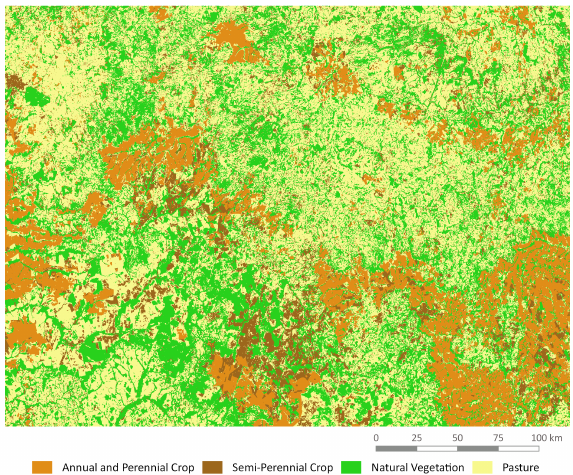
Figure 4. Random forest classification of the study area, from September 2018 to August 2019, using the CBERS-4/WFI data